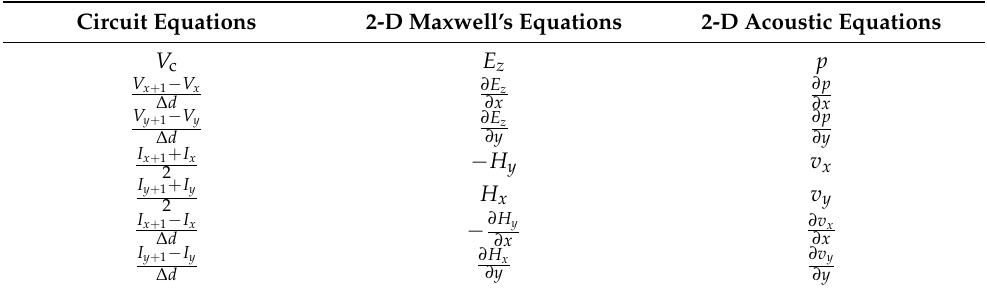
Table 2. Correspondences of voltages, currents, electric fields, magnetic fields, scalar pressures, 99 and fluid velocities in the equations of Table 1.